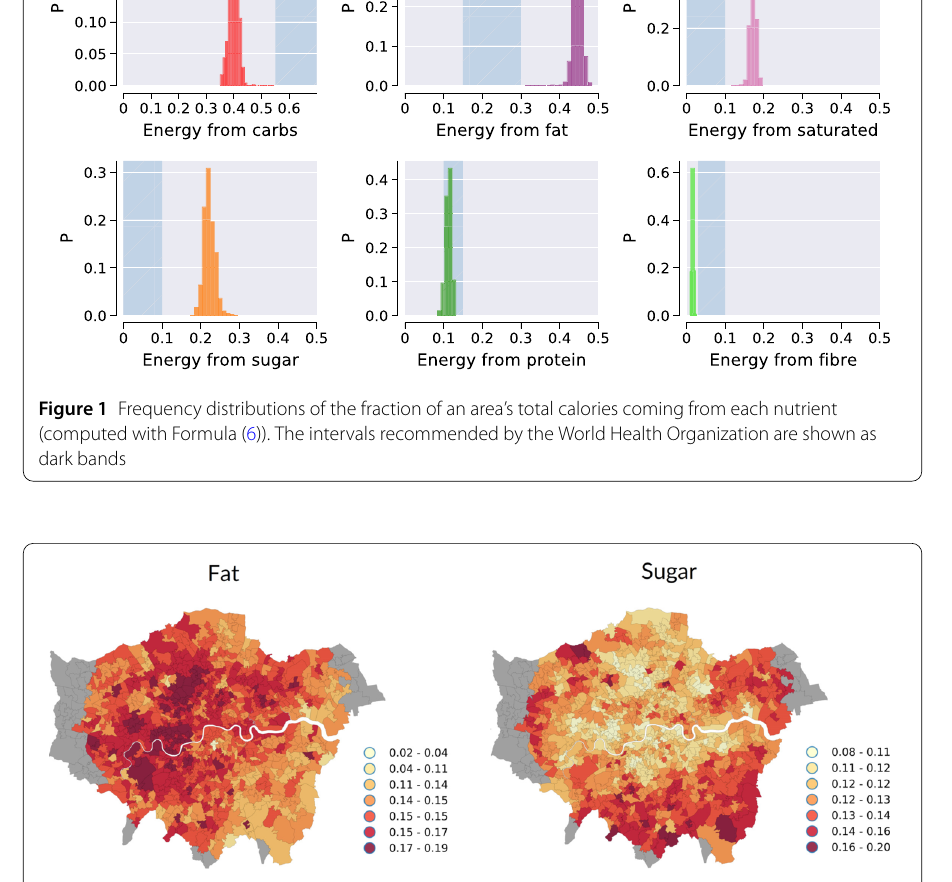
Figure 2 Percentage departures from recommended limits for the consumption of fat (left) and sugar (right). These values are computed with Formula (8). Areas in red exceed the recommended limit the most (e.g., an area with 0.16 for fat is an area in which calories from fat exceed the official limit by 16%). Areas in gray were left out because not